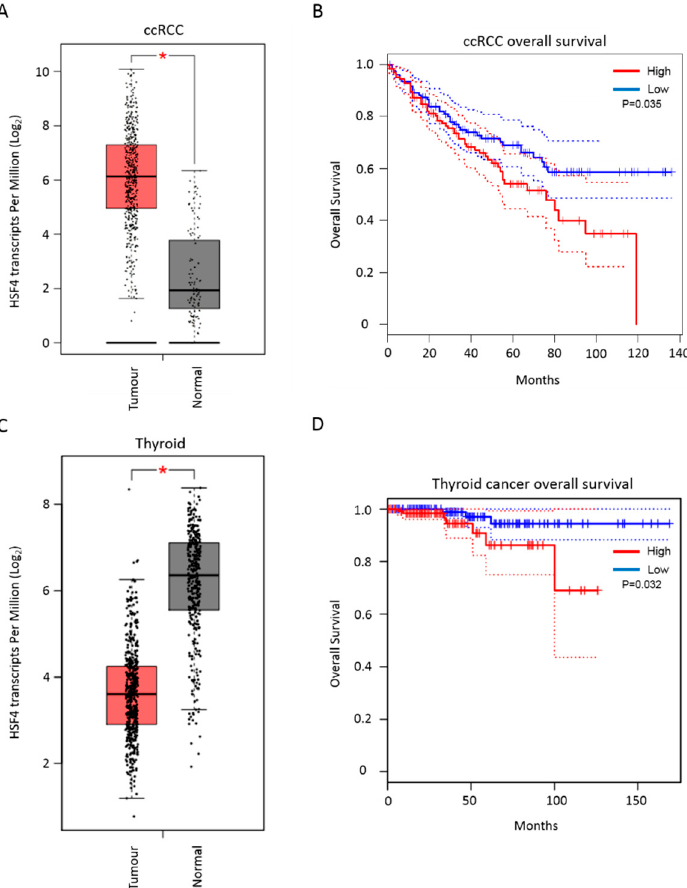
Figure 8. ( A ) Significant upregulation of HSF4 in TCGA ccRCC samples as compared to normal kidney tissues. ( B ) High expression of HSF4 was significantly associated with poor overall survival in TCGA ccRCC patient cohort. ( C ) Significant downregulation of HSF4 in TCGA thyroid cancer samples as compared to normal thyroid tissues. ( D ) High expression of HSF4 was significantly associated with poor overall survival in TCGA thyroid cancer patient cohort. Asterisk (*) indicates that there is statistically significant difference (log2FC l2l; p < 0.05) in the HSF4 expression between the tumour and normal tissues.